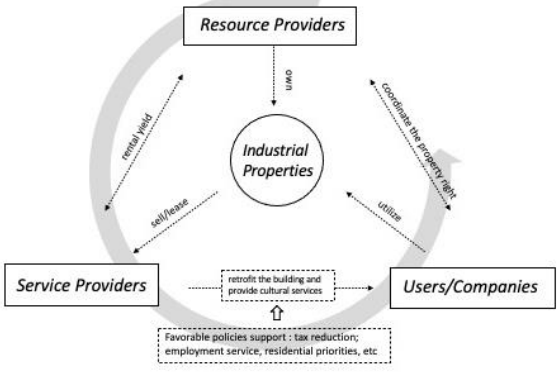
Fig 3. Adaptive reuse strategy integrated coworking service